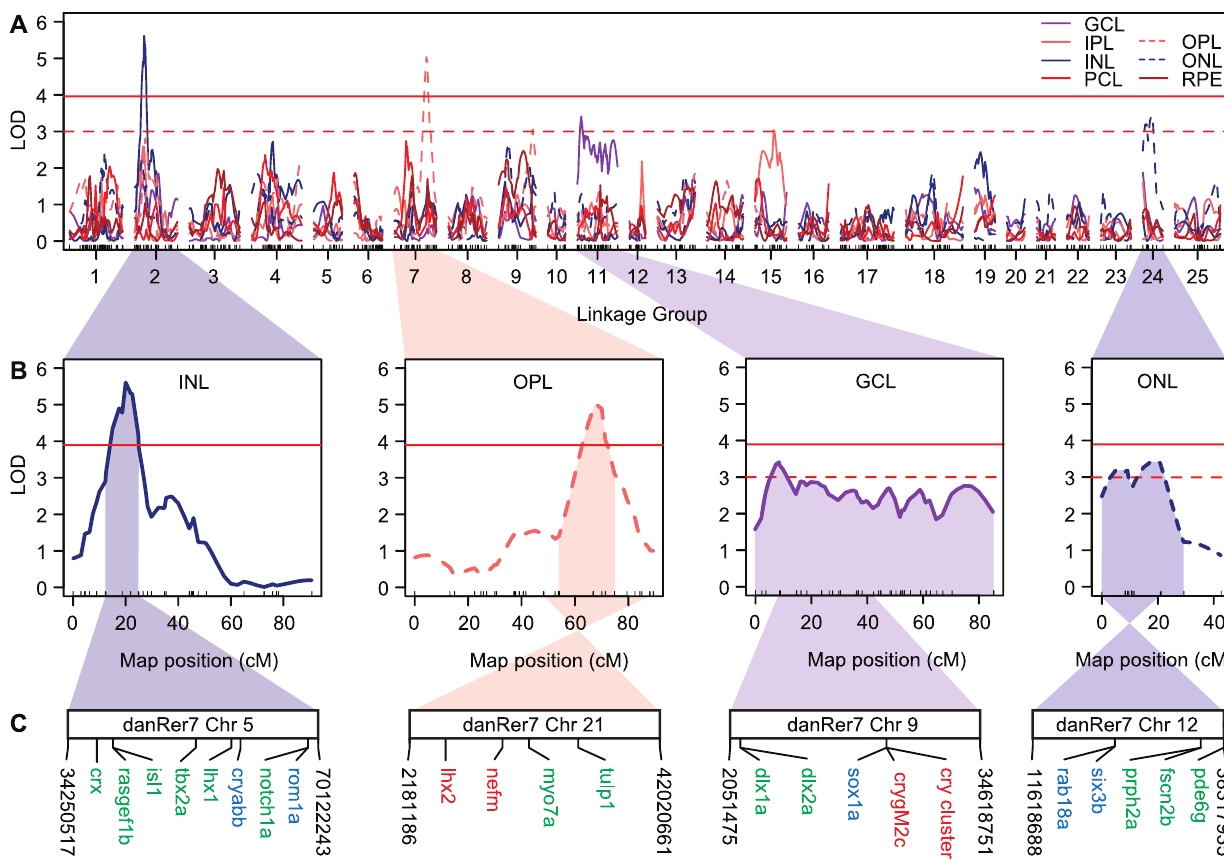
Figure 3. QTL mapping of retinal thickness in F 2 hybrids. (A) LOD scores of association between genotypes on each linkage group and the thickness of seven retinal layers. Retinal layers include the ganglion cell layer (GCL), inner plexiform layer (IPL), inner nuclear layer (INL), outer plexiform layer (OPL), outer nuclear layer (ONL), photoreceptor cell layer (PCL), and retinal pigment epithelium (RPE). Horizontal lines represent the genome-wide significant threshold at P =0.05 (solid) and 0.15 (dotted). (B) Significant QTL include those for INL thickness on Astyanax LG 2, OPL thickness on LG 7, GCL thickness on LG 11, and ONL thickness on LG 24. Highlighted regions represent the 95% Baysian credible interval for each QTL position. (C) Markers within and around each QTL region map to four , 35 Mb regions of the zebrafish ( Danio rerio ) genome on chromosomes 5, 21, 9, and 12. Within each region, we find several candidate genes that are either: (red) differentially expressed between Astyanax surface fish and cavefish; (green) implicated in vertebrate retinal degeneration; or (blue) important for eye development and function (see